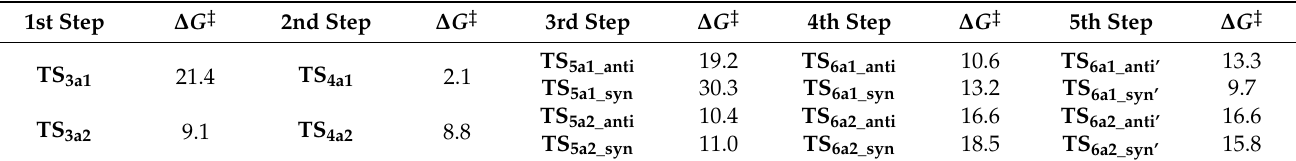
Table 1. Calculated transition states and Gibbs free energies of activation ( ∆ G ‡ , in kcal mol − 1 ) for each step of the mechanism between anthranil and ynamide MeN(Ts)C ≡